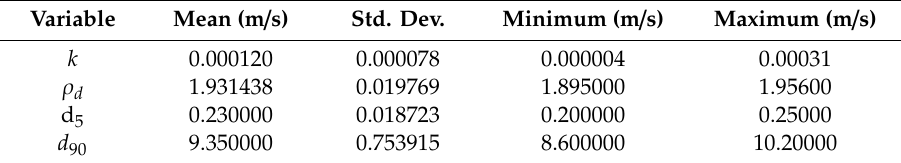
Table 6. Parameters of applicability of the